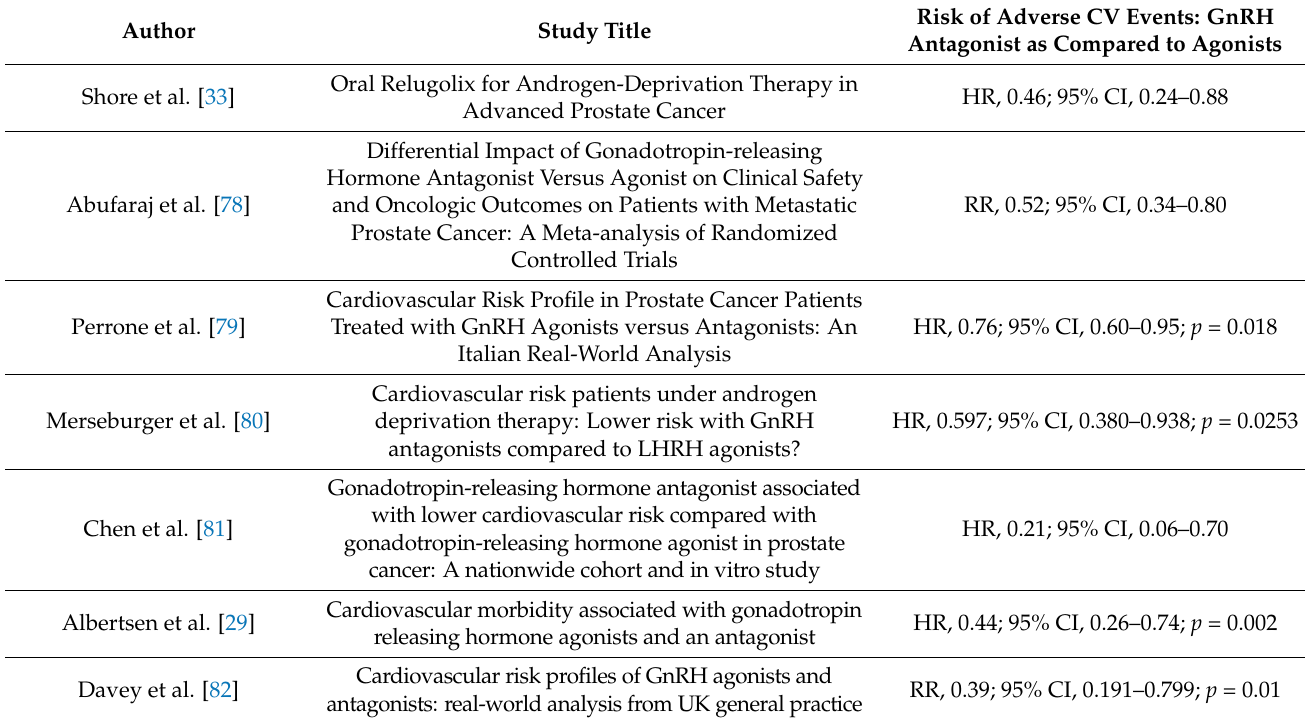
Table A3. CV Adverse Effects in Patients Receiving GnRH Antagonists vs. GnRH Agonists.